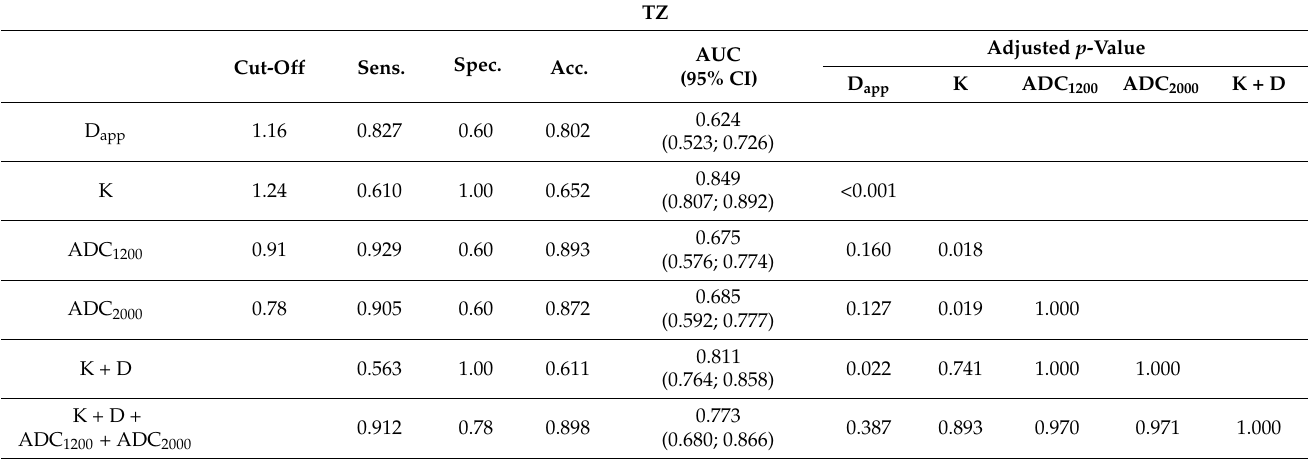
Table 6. Diagnostic performance in differentiating GS ≤ 3 + 3 and GS ≥ 3 + 4 tumors in the transi- tional zone of D app , K, ADC 1200 , and ADC 2000 , combination of D app and K together, combination of D app +K+ ADC 1200 + ADC 2000 together, and cut-off values for D, ADC × 10 − 3 mm 2 /s) and K determined by Youden index.